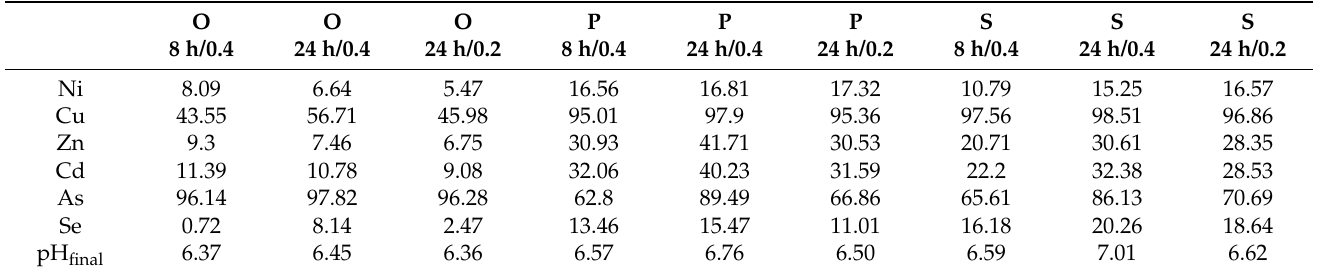
Table 7. % Metal ions removal and final pH of the leachate treatment with